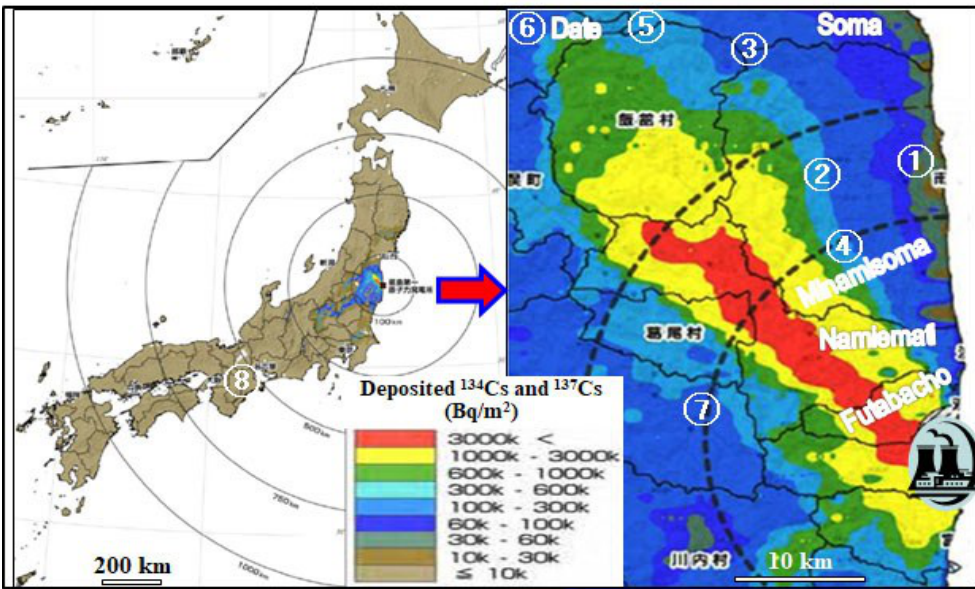
Figure 1. Exposure area of eastern Japan showing the rural land where radiocesium ( 134 Cs and 137 Cs) was deposited [3,4]. Area numbers: 1, the hospital of Minamisoma; 2 to 7, the places from which tree samples were obtained and where tree seedlings were planted; 8, the place from which control trees were obtained.